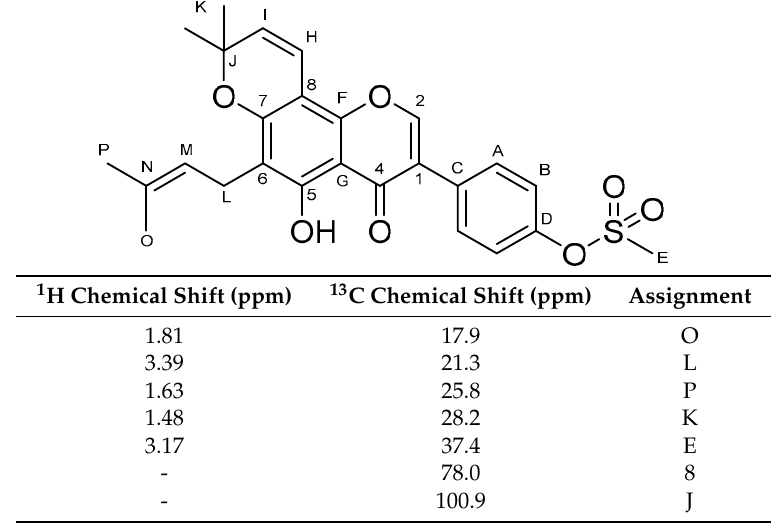
Figure 1. Minimized three-dimensional (3D) structure of compound 2 (force field: MMFF94). Chemical shifts are reported close to the corresponding nuclei and the observed nuclear Overhauser effect spectroscopy (NOESY) correlations are represented as blue arrows. Table 1. 1 H and 13 C-nuclear magnetic spectroscopy (NMR) chemical shifts and structure of 2 .